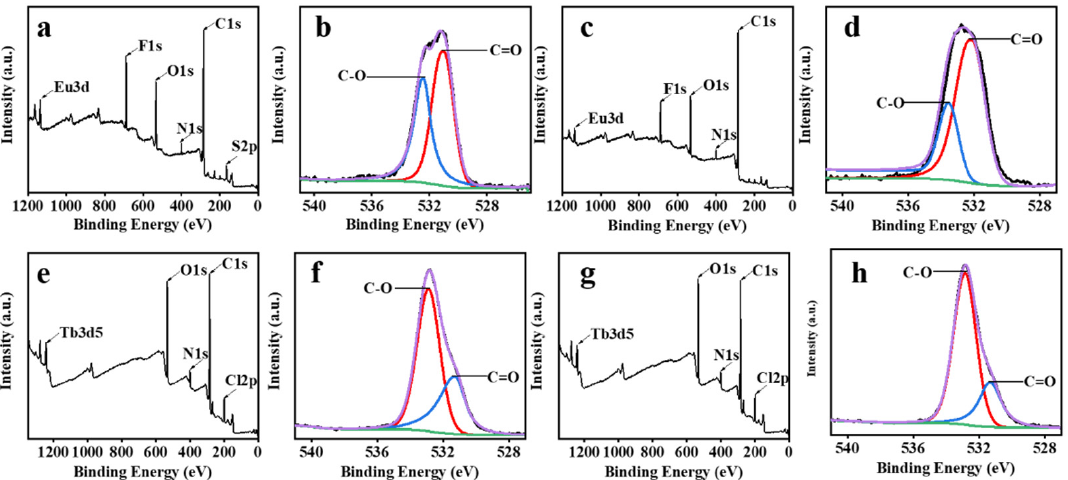
Figure 6. ( a ) XPS survey spectrum of ECA. ( b ) High-resolution O1s spectrum of ECA. ( c ) XPS survey spectrum of ECA-CPT-11. ( d ) High-resolution O1s spectrum of ECA-CPT-11. ( e ) XPS survey spectrum of TCA. ( f ) High-resolution O1s spectrum of TCA. ( g ) XPS survey spectrum of TCA-CPT-11. ( h ) High-resolution O1s spectrum of TCA-CPT-11.